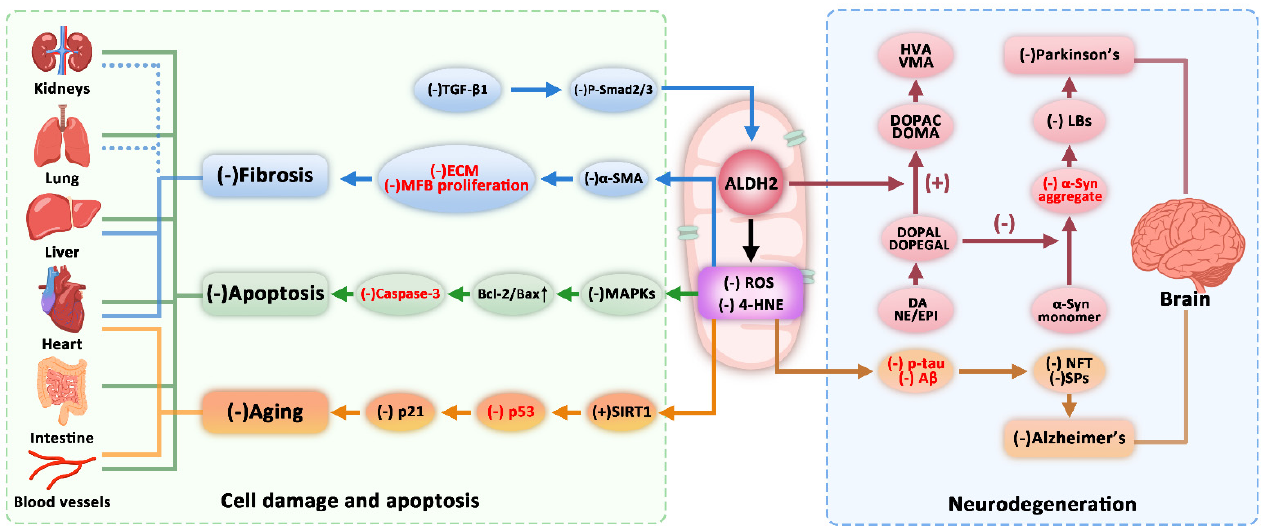
Figure 3. The main regulatory mechanism of aldehyde dehydrogenase 2 (ALDH2) in certain OS- related physiological and pathological processes. ALDH2 activation inhibits the transformation of human cardiac fibroblasts (HCFs) into myofibroblasts via the transforming growth factor- β 1 (TGF- β )/ Drosophila mothers against decapentaplegic protein (Smad) signaling pathway to inhibit fibrosis; ALDH2 inhibits mitogen-activated protein kinase (MAPK) signaling pathways and upregulates the B-cell lymphoma-2 (Bcl-2)/Bcl-2–associated X protein (Bax) ratio to reduce the cysteinyl aspartate– specific proteinase 3 (caspase-3) level and inhibit apoptosis; ALDH2 can also inactivate inhibit 4- hydroxy-2-nonenal (4-HNE) accumulation and regulate sirtuin 1 (SIRT1)/p53-dependent aging; ALDH2 can eliminate the toxic metabolites of neurotransmitters (dopamine [DA], epinephrine [EPI], and norepinephrine [NE]) and can inhibit α -Synuclein ( α -Syn) abnormal aggregation as well as Lewy bodies (LBs) formation, and reduce neurofibrillary tangles (NFTs) formed by hyperphos- phorylated microtubule-associated protein tau, so as to protect neurons from the damage caused by 4-HNE and reactive oxygen species (ROS). (+) and ( − ) mainly reflect upregulation/activation or downregulation/inhibition, respectively, related to ALDH2 function. Red = plays a key role in the realization of corresponding physiological/pathological processes. Table 2. Function and regulatory pathways of ALDH2 in oxidative stress-related diseases and in- jury.